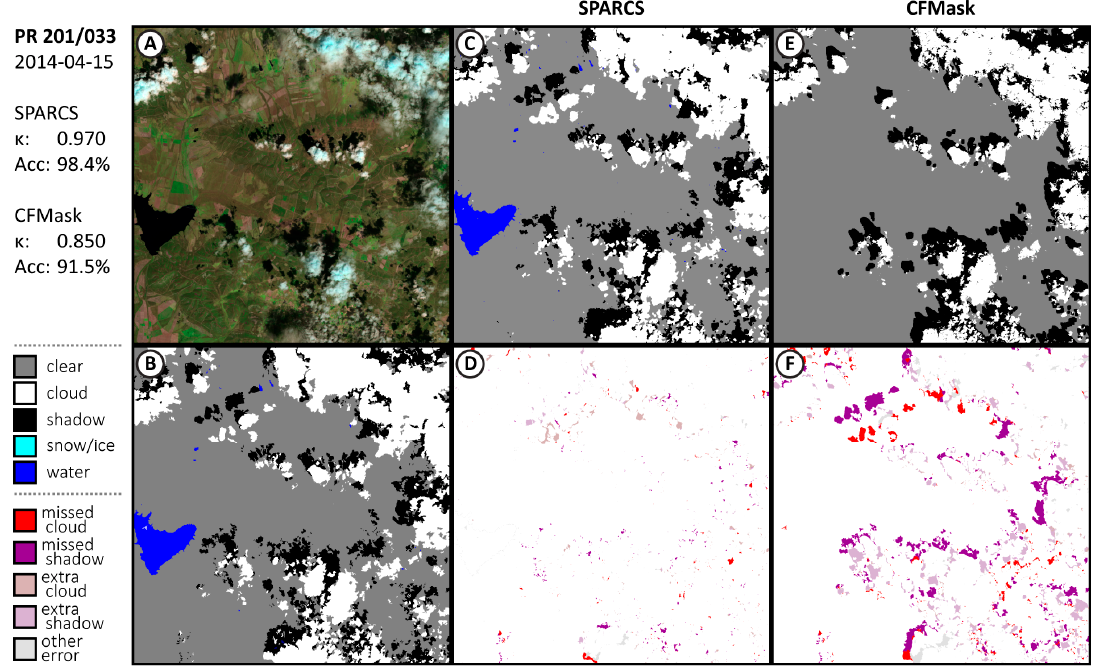
Figure 3. Results over test image at path/row 201/033, showing false color image used during interpretation (A), the manually labeled interpretations (B), with generated masks from SPARCS (C) and CFMask (E) with respective spatial distribution of errors (D, F).